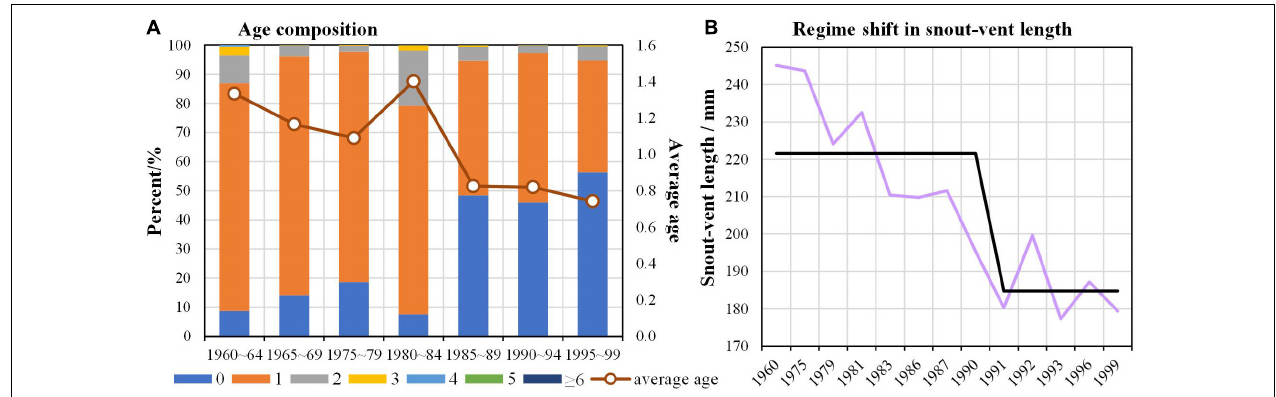
FIGURE 5 | Changes in life history traits of hairtail ( Trichiurus japonicus ) from the East China Sea: (A) Variations in age composition; (B) Changing trend in snout-vent length with a step change.